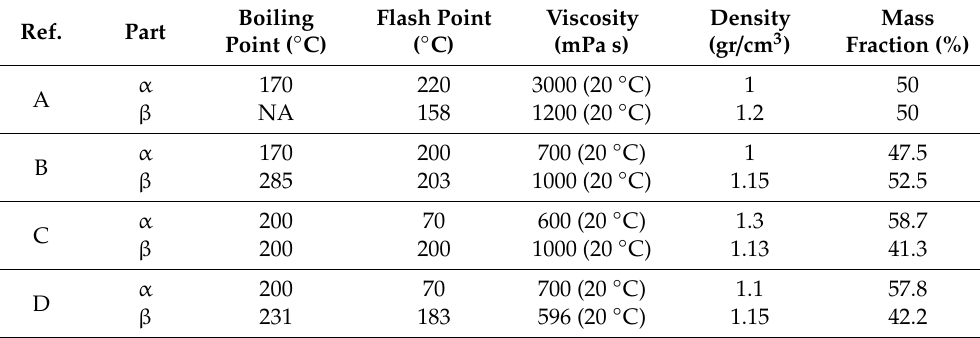
Table 1. Properties of the polyurethanes.